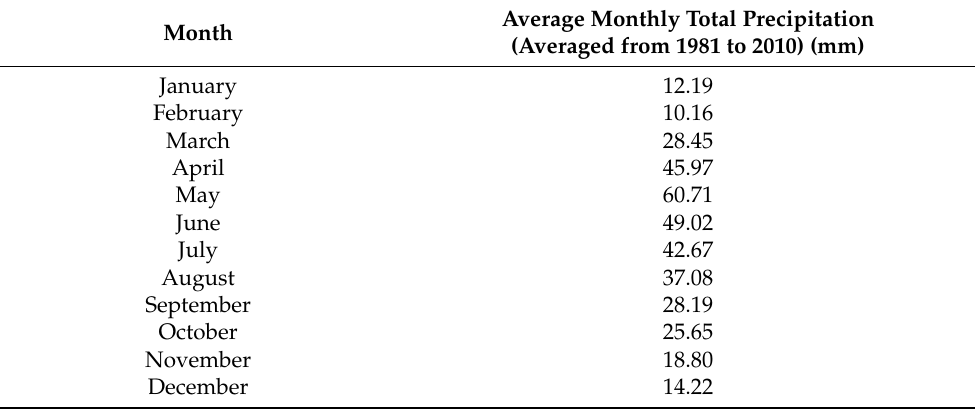
Table 4. Average monthly total precipitation based on precipitation measurements taken at the NOAA Greeley UNC station 05-53553 from 1981 to 2010. The data below do not account for snow